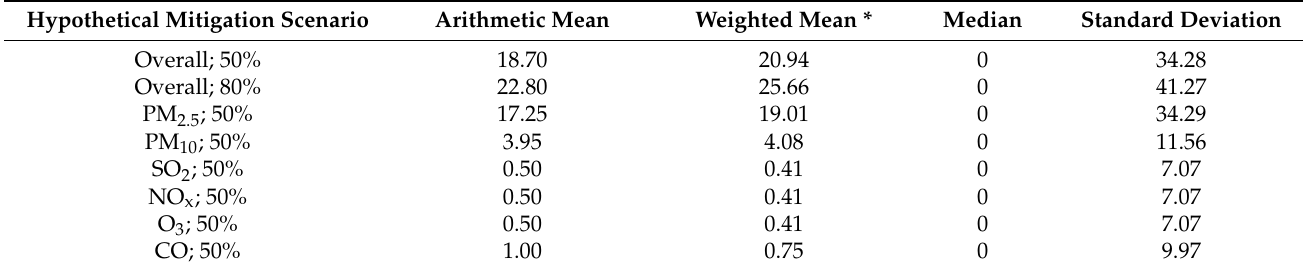
Table 9. Descriptive statistics of individual willingness to pay (WTP) (THB per month) for mitigation of atmospheric pollutants under different hypothetical scenarios ( n =